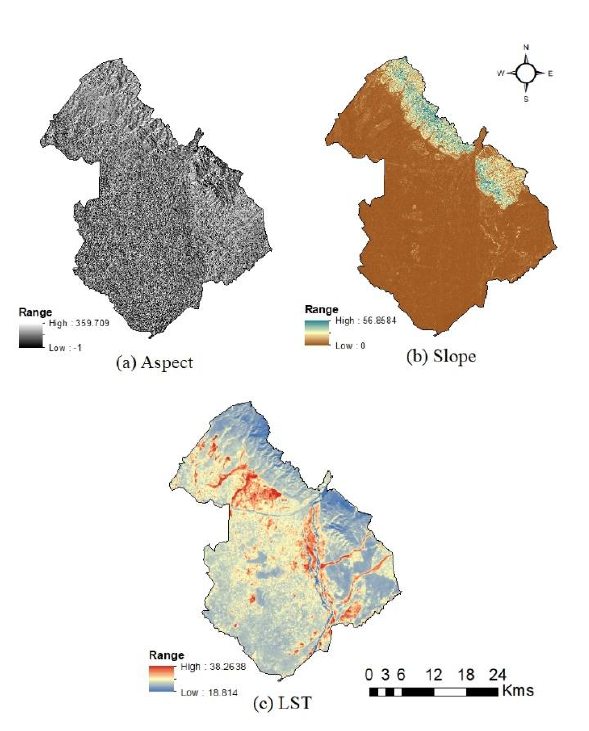
Figure 6. Gini importance scores of selected features